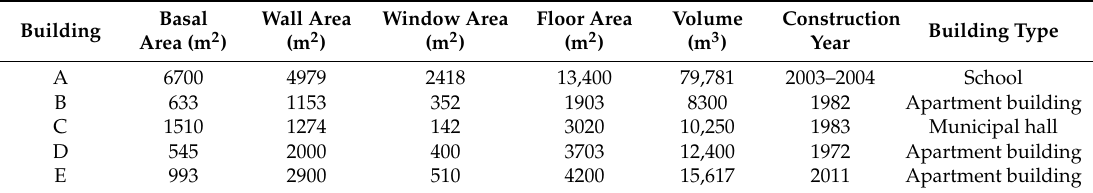
Table 1. Building